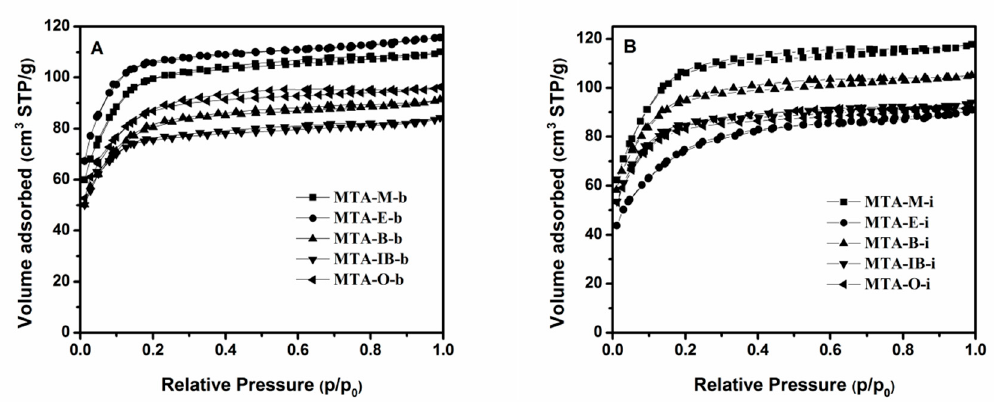
Figure 2. N 2 adsorption–desorption isotherms of samples MTA-b ( A ) and MTA-i ( B ) calcined at 400 °C.